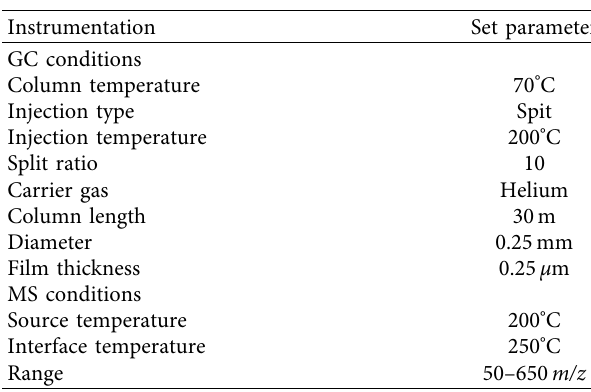
Table 2: GC-MS condition.